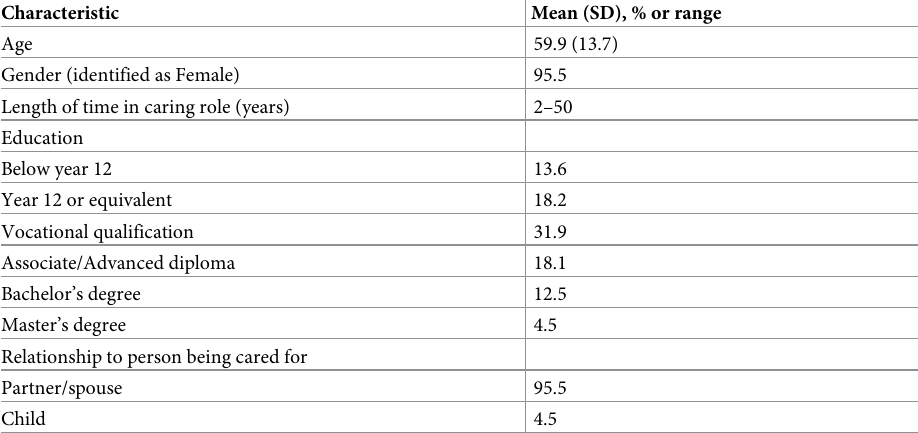
Table 1. Demographic characteristics of interview participants (n =